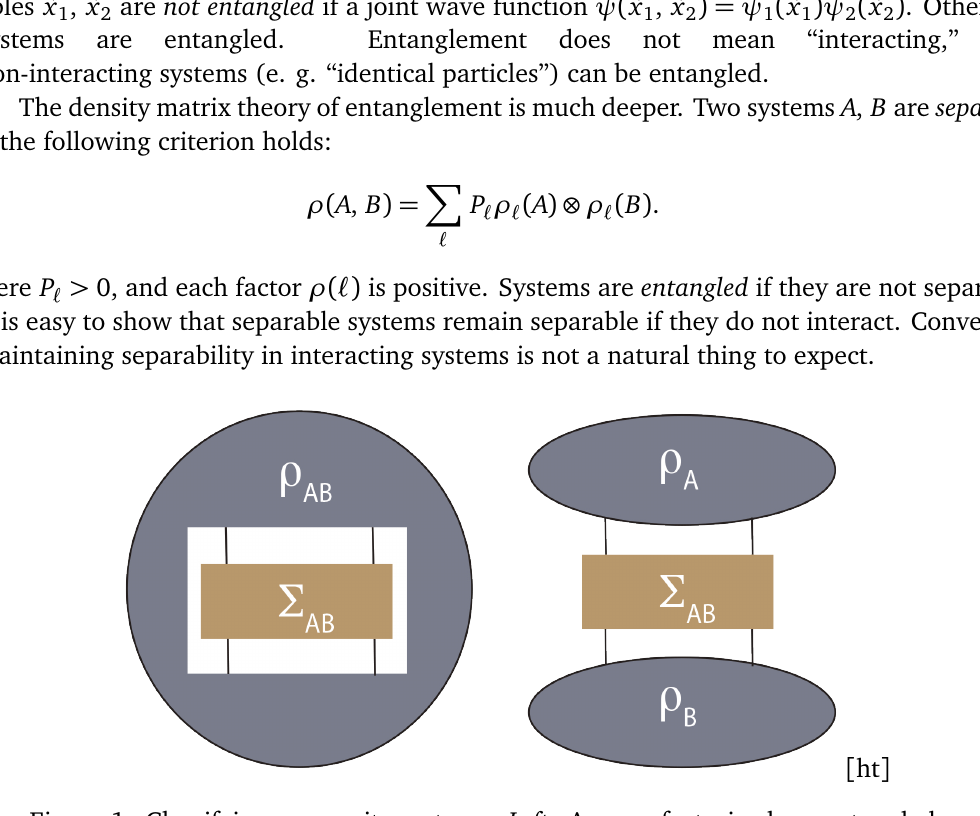
Figure 1: Classifying composite systems. Left: An non-factorized, or entangled sys- tem, with a generic probe. Right: A factorized, or separable system conditional upon a special class of probe Σ AB